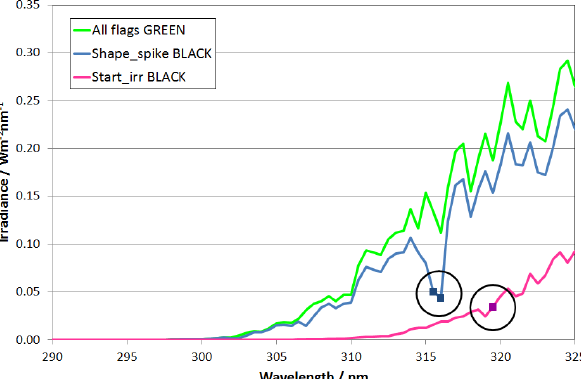
Figure 4. Exemplar spectra of three different cases. (1) Case of a GREEN flag given to all individual indicators. Spectrum measured by Brewer #037 in Sodankylä on 21 June 2003, at